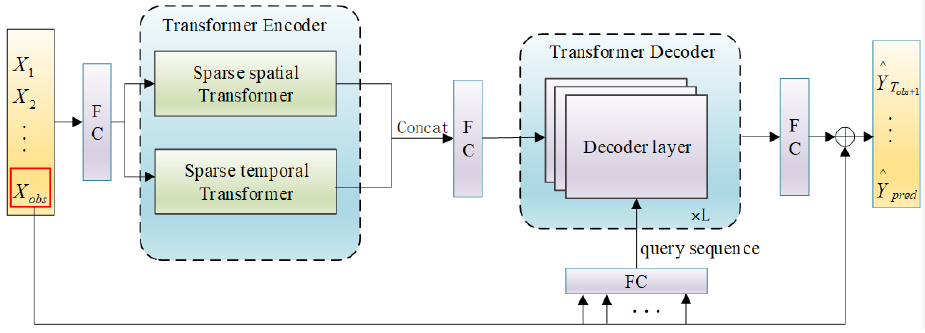
Figure 1. Overview architecture of the proposed Non-autoregressive Sparse Transformer (NaST) networks for pedestrian trajectory prediction.